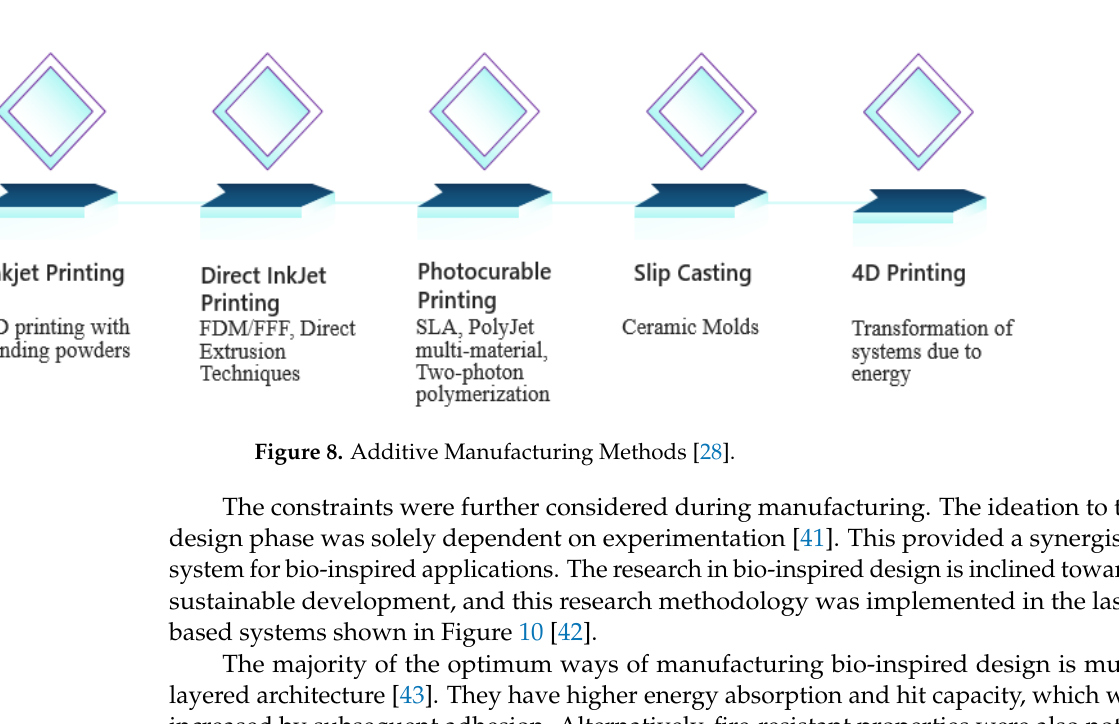
Figure 7. A framework for the application of biomimicry [37].